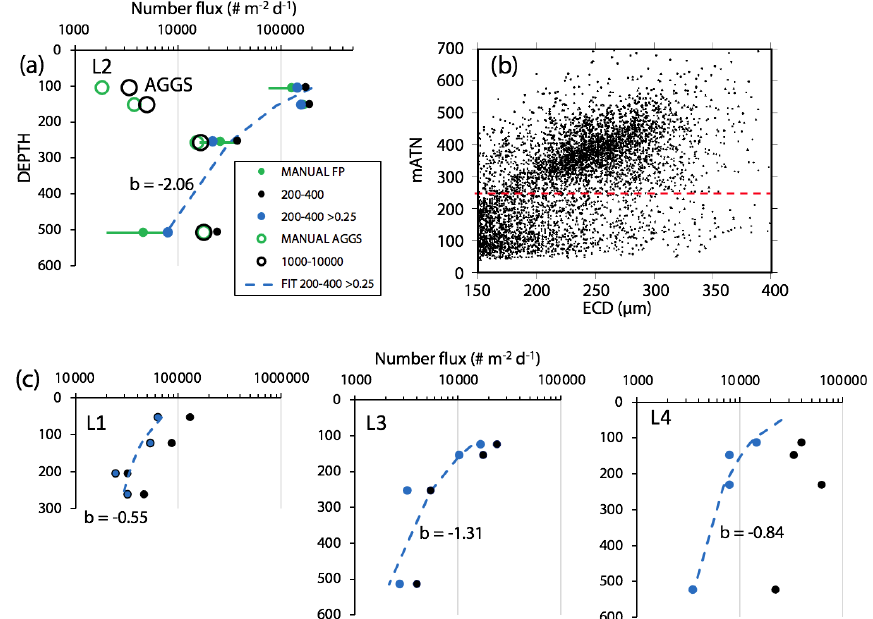
Figure 8. (a) Profile of aggregate and pellet number fluxes determined by method 3 and by manual counting at Location L2. The small blue-filled circles represent number flux of 200–400µm particles with average attenuance > 0 . 25. These data agree closely with manually enumerated pellet counts. Method 3 counted more aggregates in the shallowest samples because the manual method was unable to infer weakly defined boundaries of less dense aggregates. Data are tabulated in Appendix A, Table A1. (b) Plot of average particle attenuance vs. equivalent circular diameter (ECD). The red dashed line denotes the lower boundary of the cluster of > 0 . 25ATN particles. (c) Profiles of 200–400µm total particle number fluxes and for > 0 . 25ATN particles at L1, L3, and L4. Dashed lines are Martin fits to the ovoid pellet class fluxes. In all cases, fluxes of faecal pellets decrease with